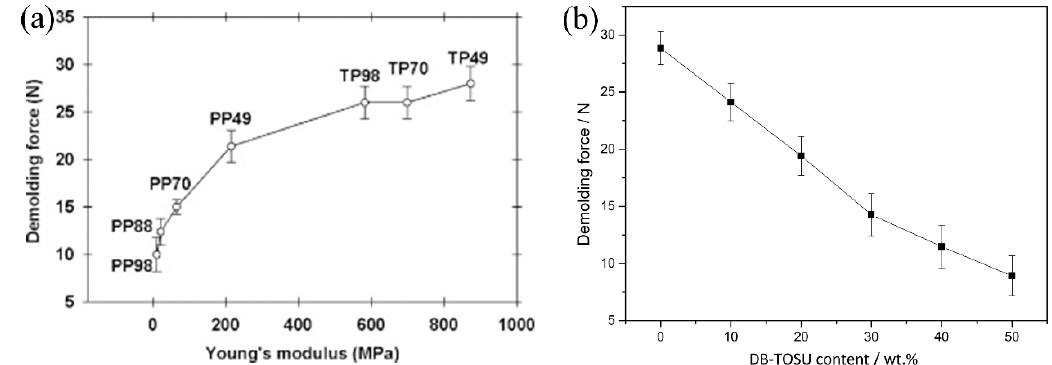
Figure 11. ( a ) Demolding force dependence on resist’s Young’s modulus and crosslinking agent content for polypropyleneglycol diacrylate (PP) and tripropyleneglycol diacrylate (TP). The coding digits show the amount of the base (TP or PP) in weight percent, e.g., PP98 represents 98 wt% base PP, 2 wt% photoinitiator (kept constant), and 0 wt% crosslinking agent. Reprinted with permission from [120]. Copyright 2011 Elsevier. ( b ) Demolding force as a function of volume-expanding monomer 3, 9-Diethyl-3, 9-bis (allyloxymethyl)-1, 5, 7, 11-tetraoxastetraoxaspiro undecane (DB-TOSU) content. Reprinted with permission from [110]. Copyright 2019